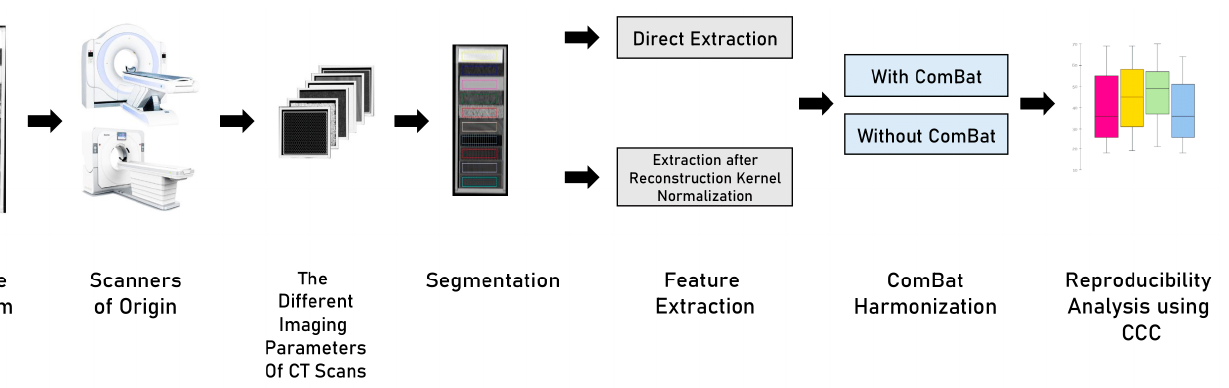
Figure 1. The study